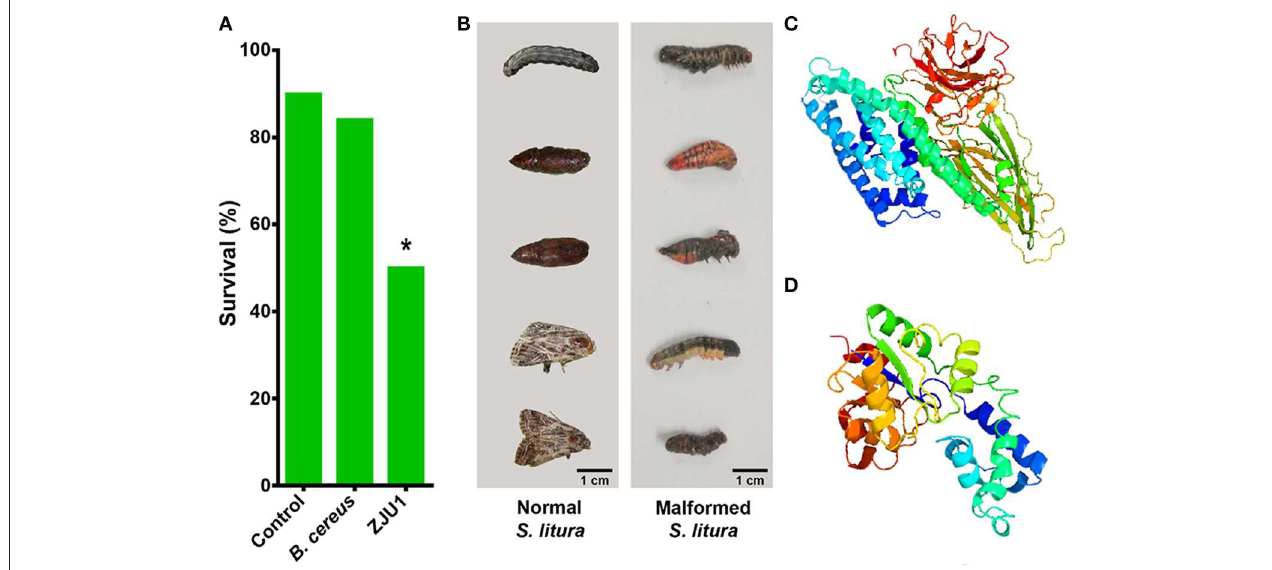
FIGURE 5 | Strain ZJU1 antagonizes the herbivorous insect pest S. litura . (A) Oral insecticidal activity of strain ZJU1. (B) Left panel, normal S. litura not exposed to strain ZJU1; right panel, larval and pupal deformities caused by ZJU1. (C) Tertiary structure prediction for Cry10Aa of B. thuringiensis and (D) B. amyloliquefaciens by Phyre2. Image colored by the rainbow N/C terminus. *Represents a significant